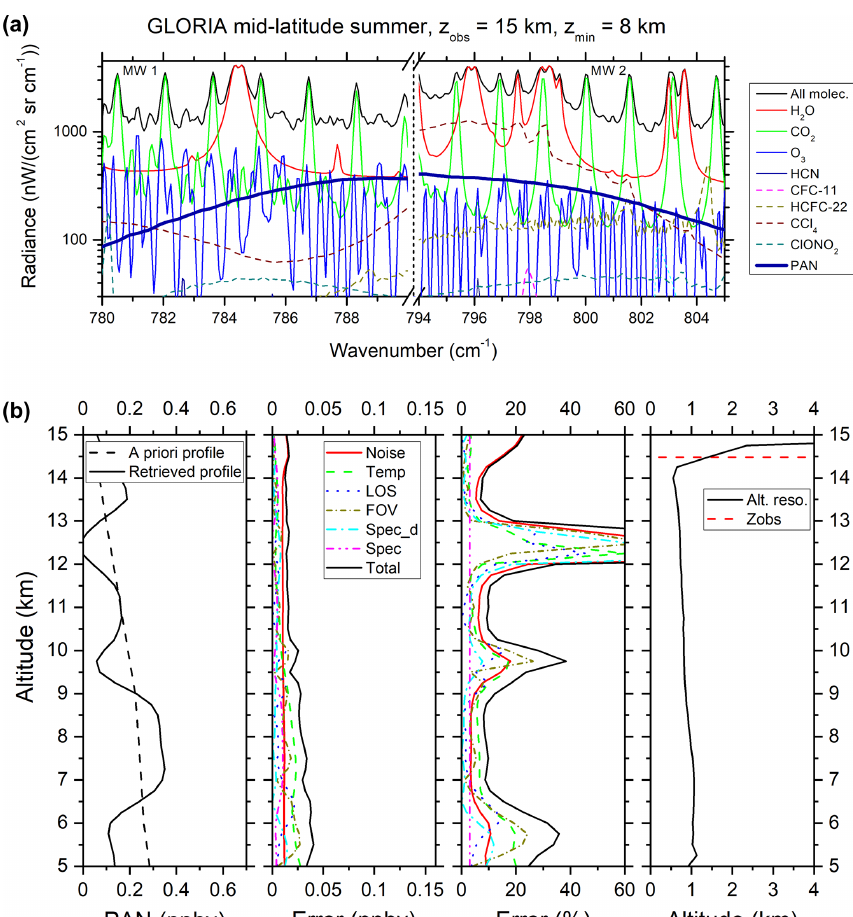
Figure 5. Simulated limb emission spectra for two microwindows within the PAN ν 16 band centred near 792cm − 1 for a tangent altitude of 8km (a) and the error budget for a PAN vertical profile obtained on 13 September 2017 at 16:55UTC (b) . Annotation as per Fig. 2.